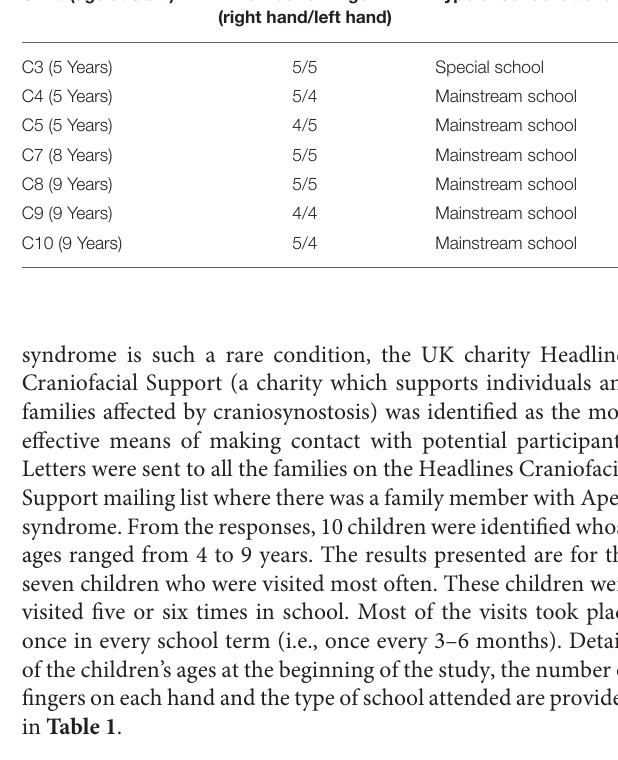
TABLE 1 | Age of children at the beginning of the study, number of fingers, and type of school attended. Child (age at start) Number of finger (right hand/left